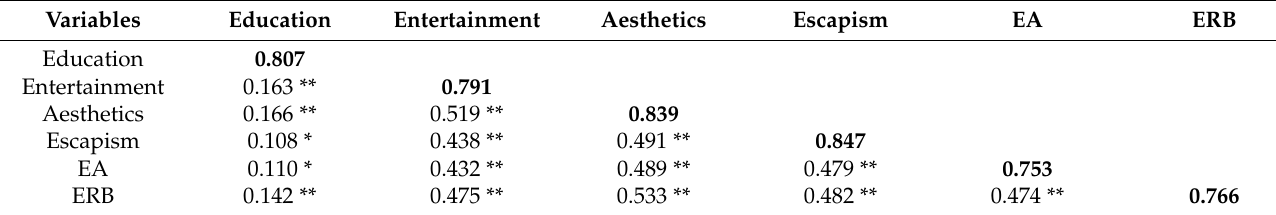
Table 3. Discriminant validity.